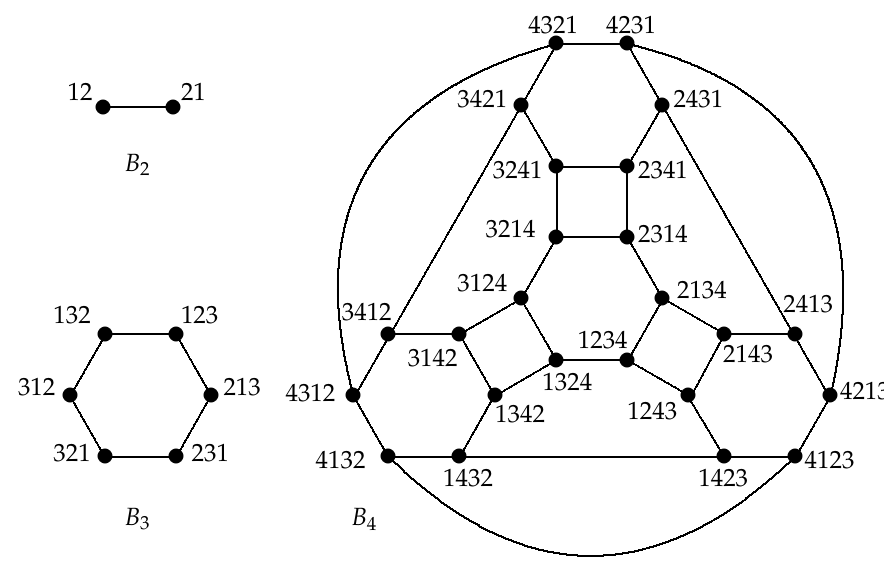
Figure 1. The bubble-sort graphs B 2 , B 3 and B 4 Fig. 1. The bubble-sort graphs B 2 , B 3 and B 4